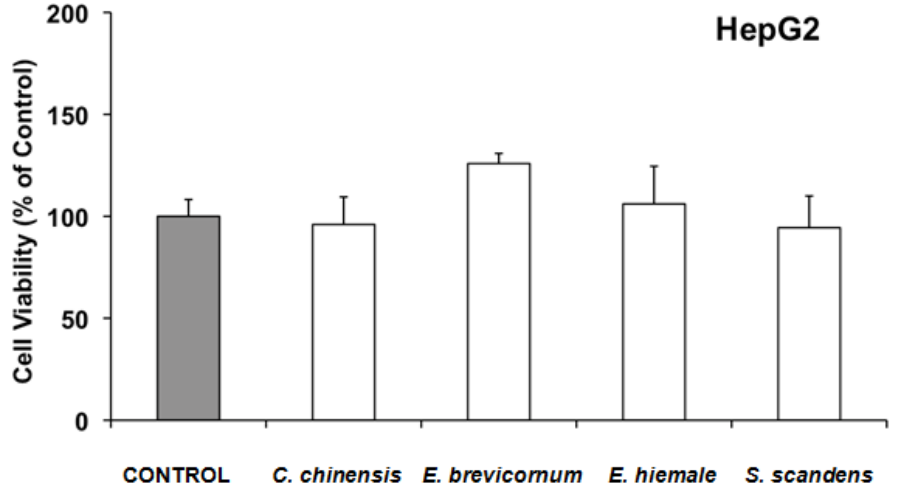
Figure 2. Acute cell toxicity as determined by 3-(4,5-dimethylthiazol-2-yl)-2, 5-difenyltetrazolium (MTT) assay in human hepatoblastoma HepG2 cells. Values are means ± SD of four experiments carried out in